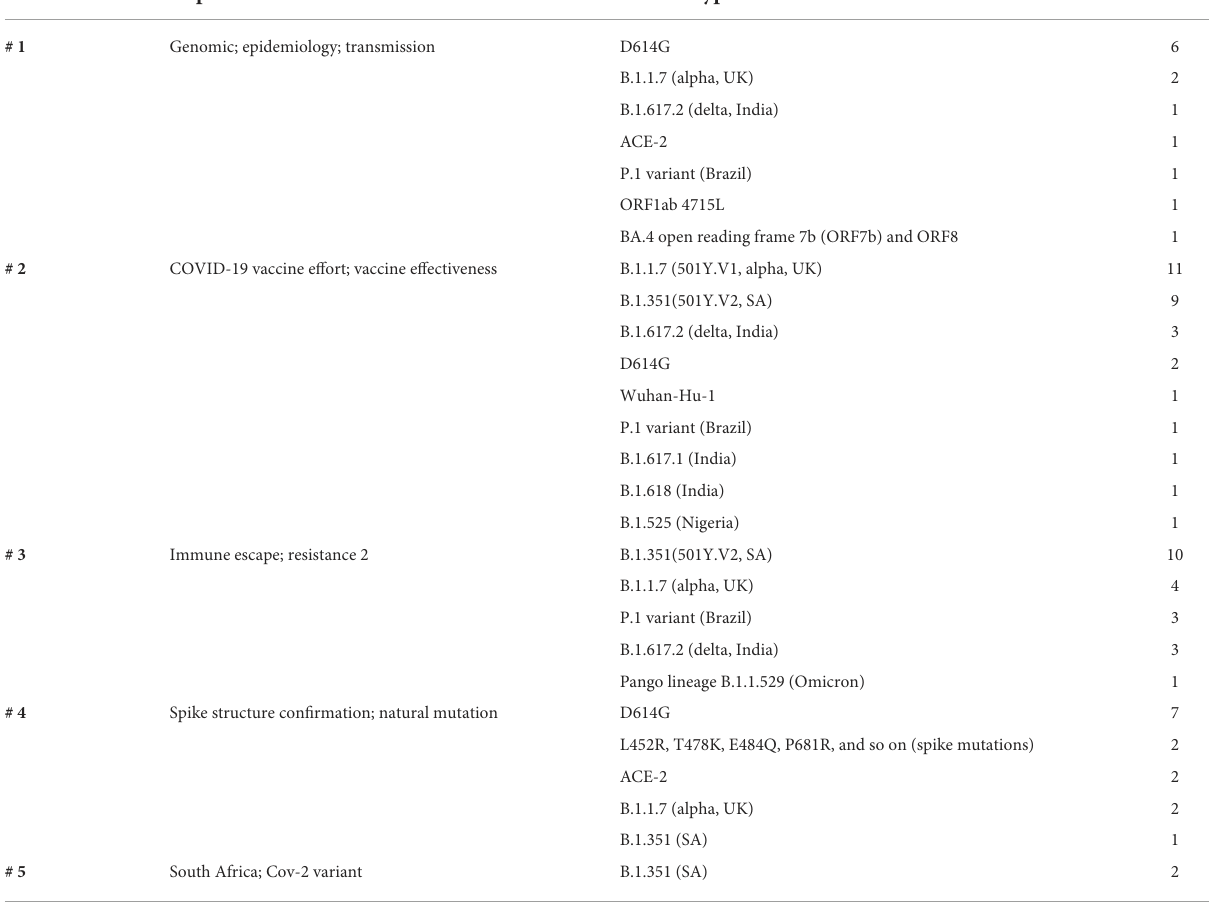
TABLE 5 Variant types or associated mutations and their occurrence frequencies in different topic clusters.